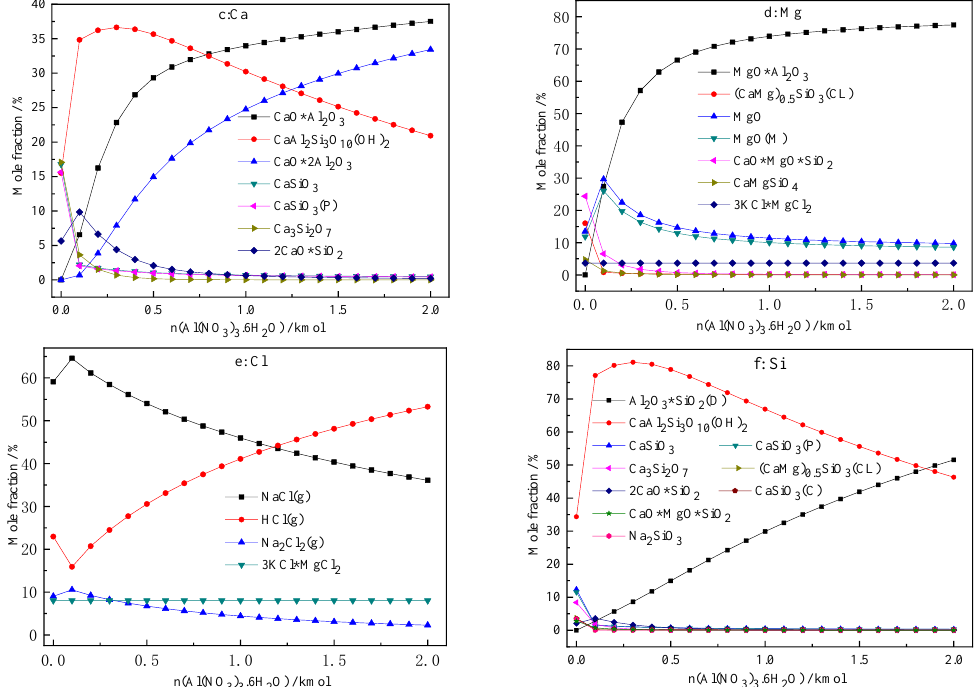
Figure 2. Effect of the amount of Al(NO 3 ) 3 addition on the migration and transformation of main elements in ash. ( a ): Na, ( b ): K, ( c ): Ca, ( d ): Mg, ( e ): Cl, ( f ): Si. The asterisk in the chemical formula shows that the molecules or species are attached with each other as independent species, similarly hereinafter.